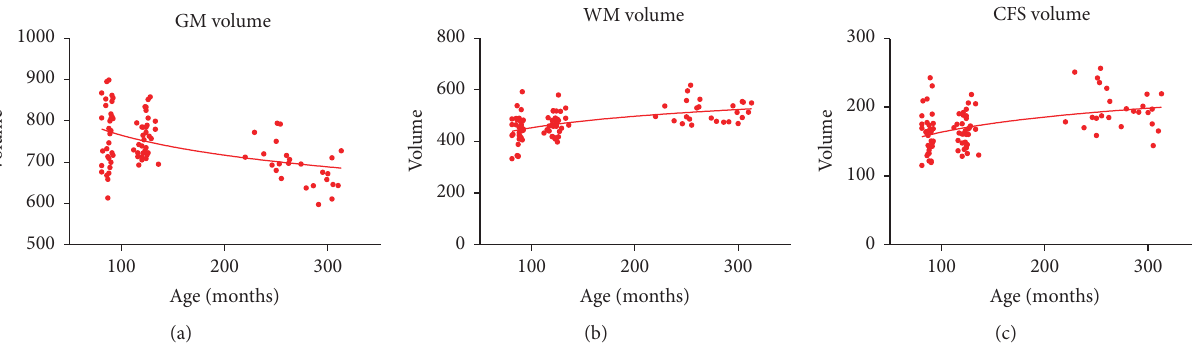
Figure 5: Volume graphs. Scatterplots of the linear effects of age on total brain gray matter (a), white matter (b), and CFS (c) volume.